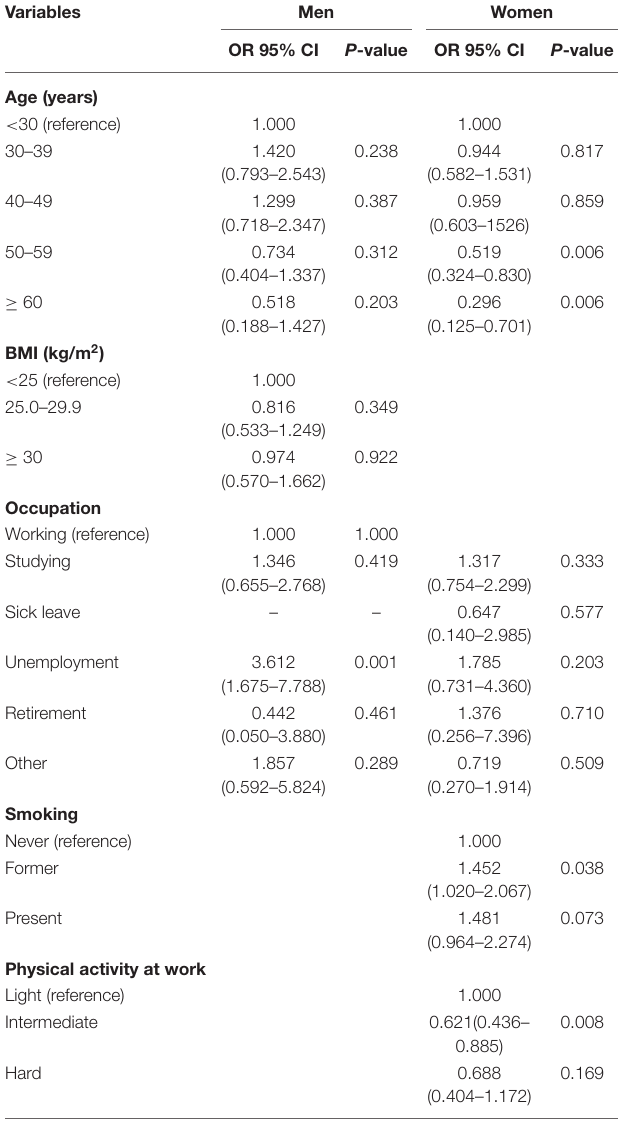
TABLE 7 | Association between sociodemographic factors, lifestyle habits and GI symptoms past 2 weeks stratified by sex.